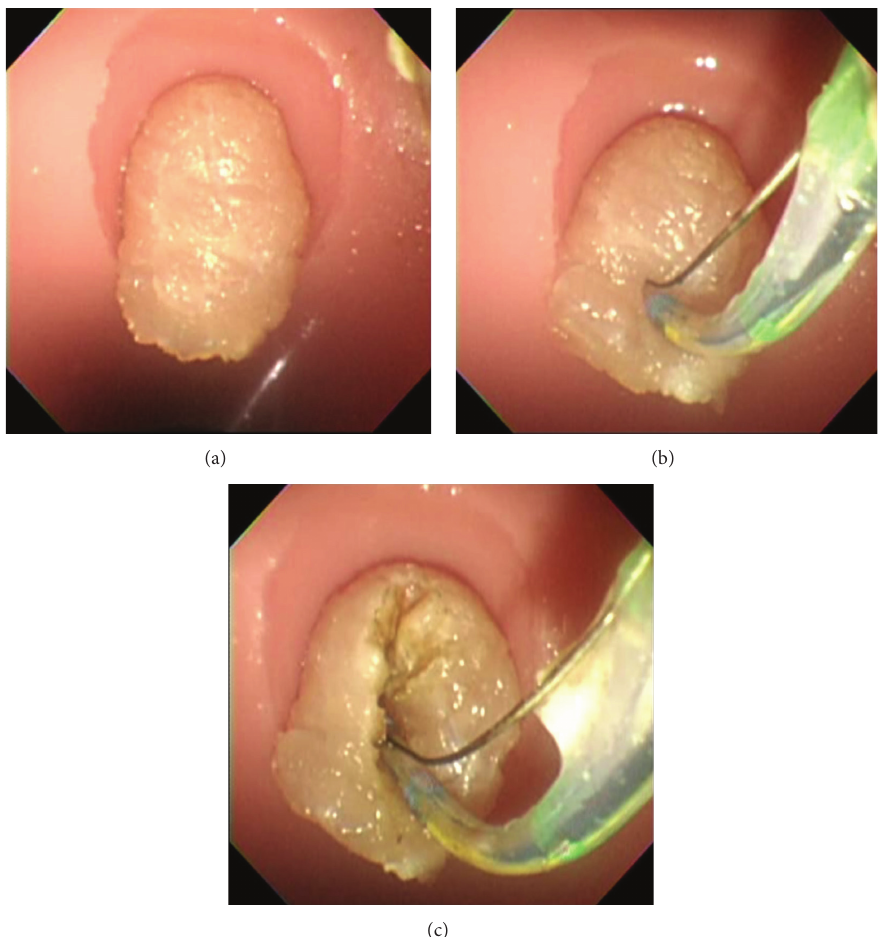
Figure 3: (a) Endoscopic observation of the papilla. (b) Insertion of the Autotome into the simulated papilla. (c) Performance of ES while the cutting direction was controlled by manipulating the endoscope and elevator function.